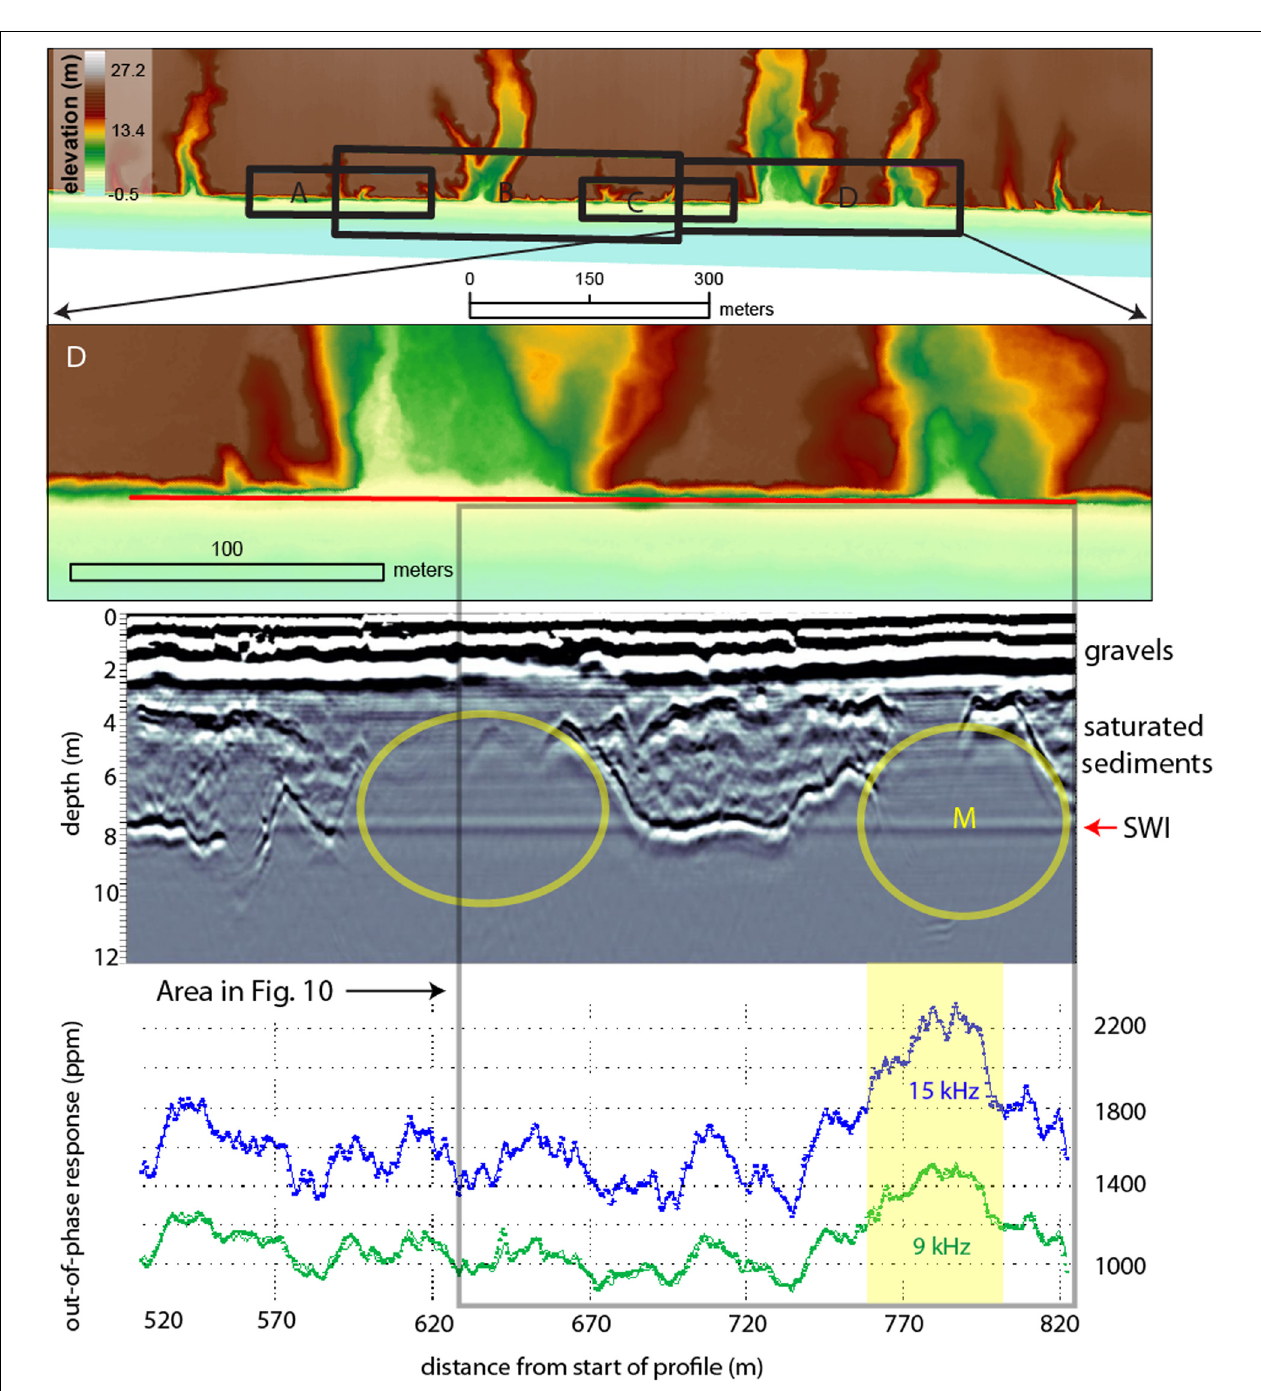
FIGURE 9 | Collocated GPR and EMI survey lines along profile D. Interpreted conduits are marked by yellow circles. Areas where the EMI maxima (highlighted in yellow) match well with the disruption in the radar reflector are marked with an ‘M’ on the GPR section.